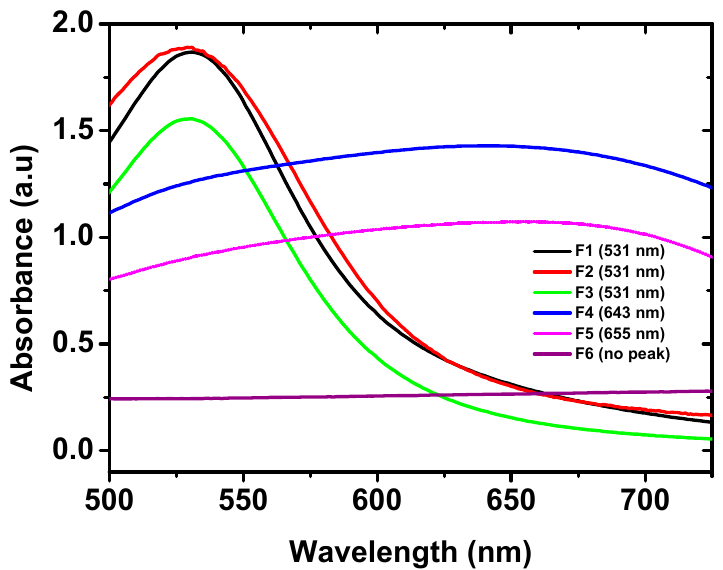
Figure 2. UV-Vis spectra of di ff erent EGCG-GNPs formulations in distilled water showing well-defined SPR peaks at λ max of 531 nm for formulations F1, F2 and F3. Formulations F4 and F5 show broad peaks at λ max of 643 and 655 nm, respectively while F6 show no definite peak.